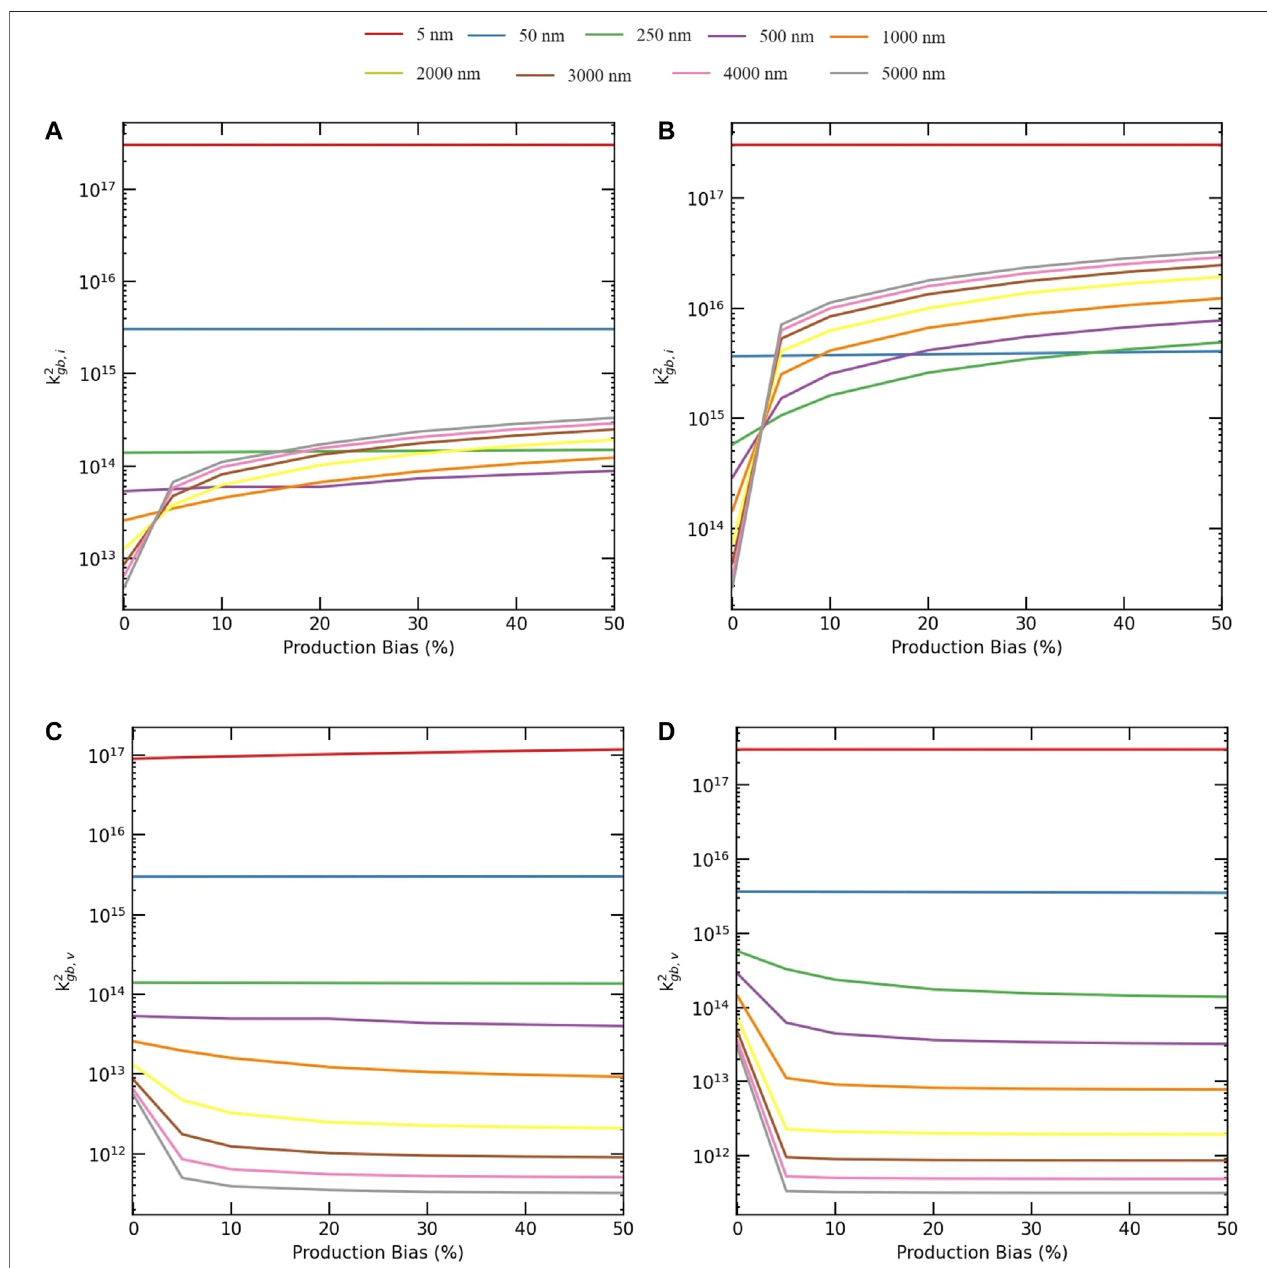
FIGURE 11 | Change of total grain boundary sink strengths with production bias and grain size. Upper row : Interstitials, k 2 gb , i , for (A) low dose rate (1e-6 dpa/s), and (B) highdoserate(1e-3 dpa/s). Lowerrow :Vacancies, k 2 gb , i ,for (C) lowdoserate(1e-6 dpa/s),and (D) highdoserate(1e-3 dpa/s).Thetrendsforthedependence of the total boundary sinks on production bias are similar to the trends for the individual boundary sink strengths discussed in Figure 10